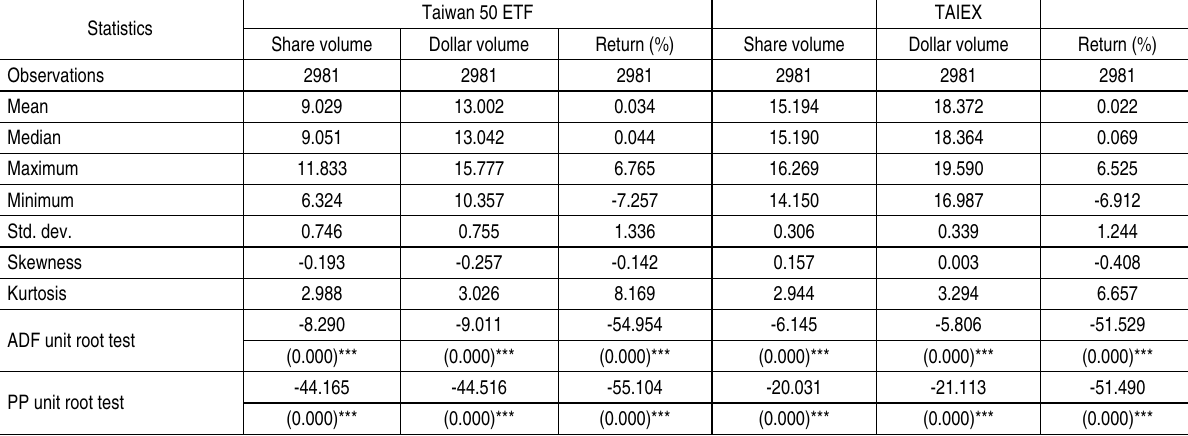
Table 1. Descriptive statistics for the share volume, dollar volume, and returns series of the ETF and the equity index: full sample, June 30, 2003 to June 30, 2015